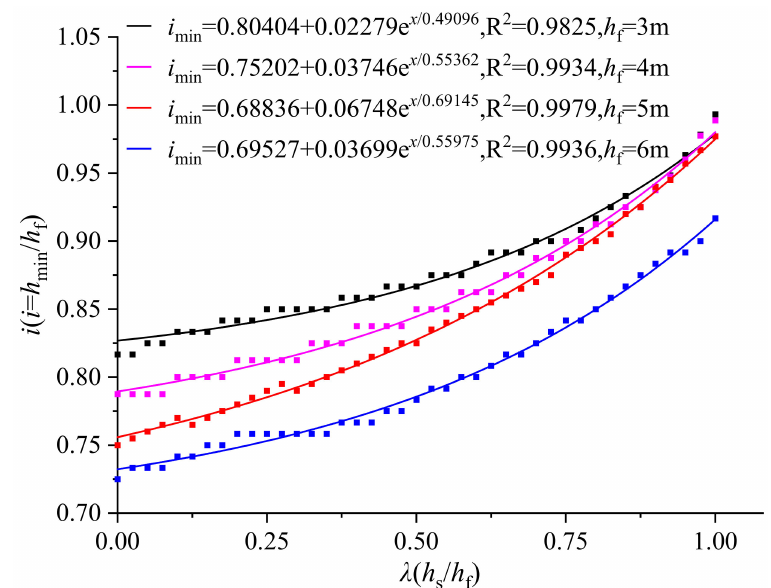
Figure 10. i versus λ .